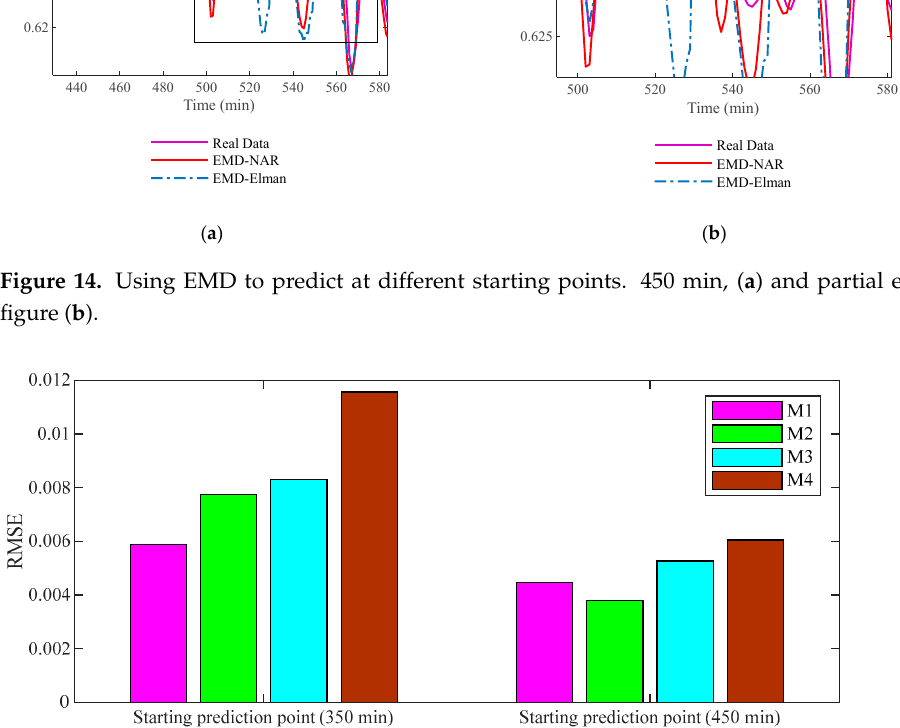
Figure 16. Different prediction starting points (350 min and 450 min) under the evaluation index (MAPE).